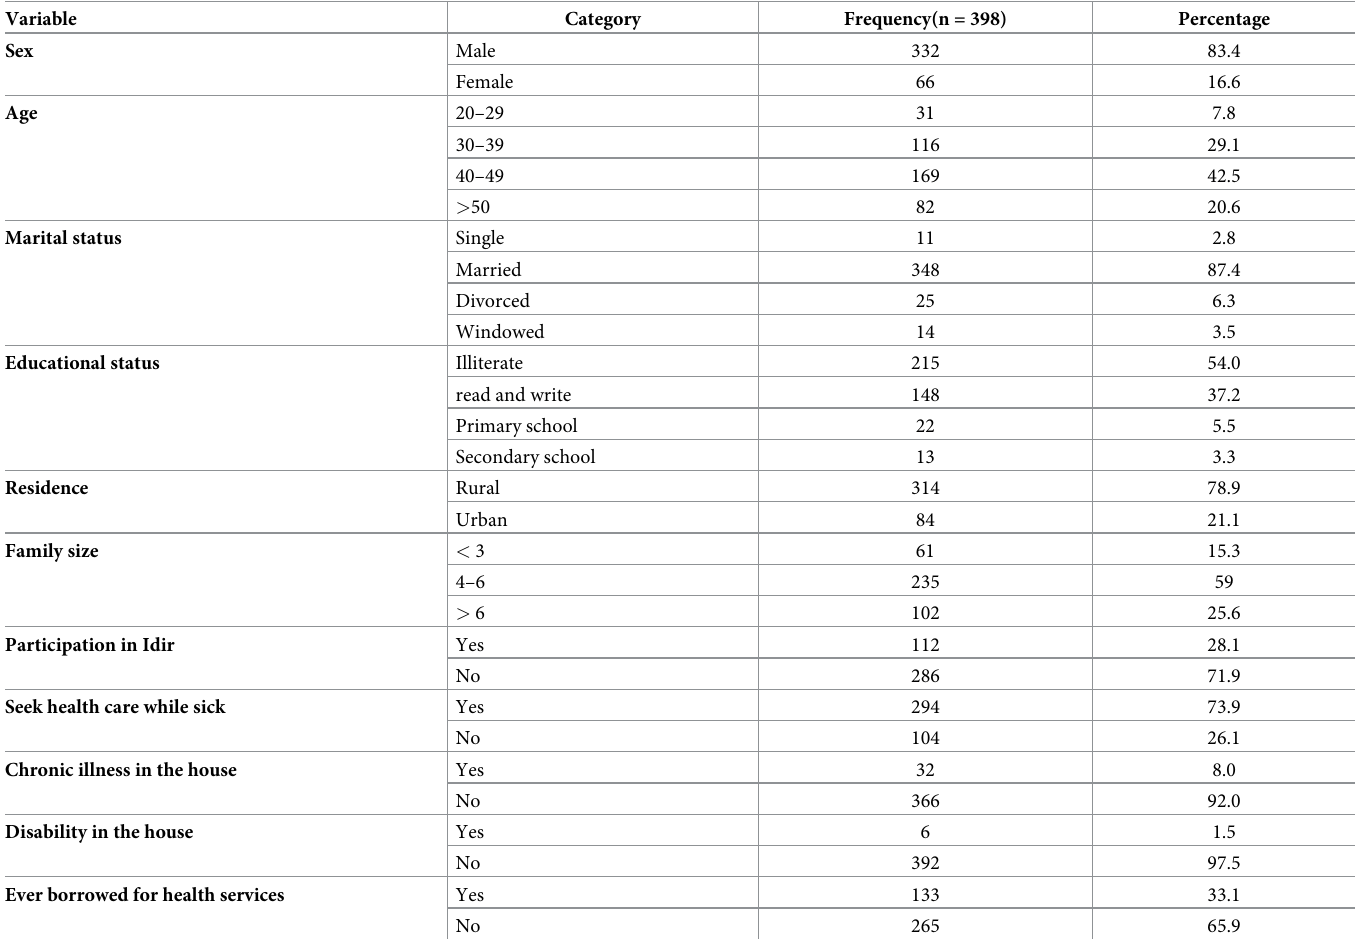
Table 1. Sociodemographic characteristic of the respondents in WerebBabu district, Northeast Ethiopia, July, 2020.